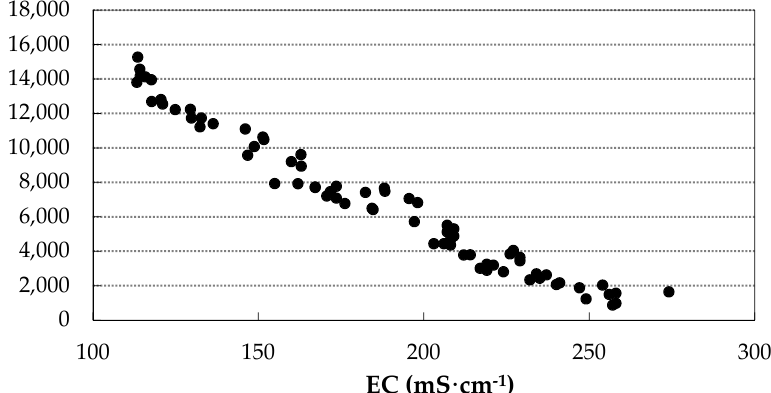
Figure 7. TAN concentration values versus EC of the acidic solution for the pig farm experiment up to the first pH correction.